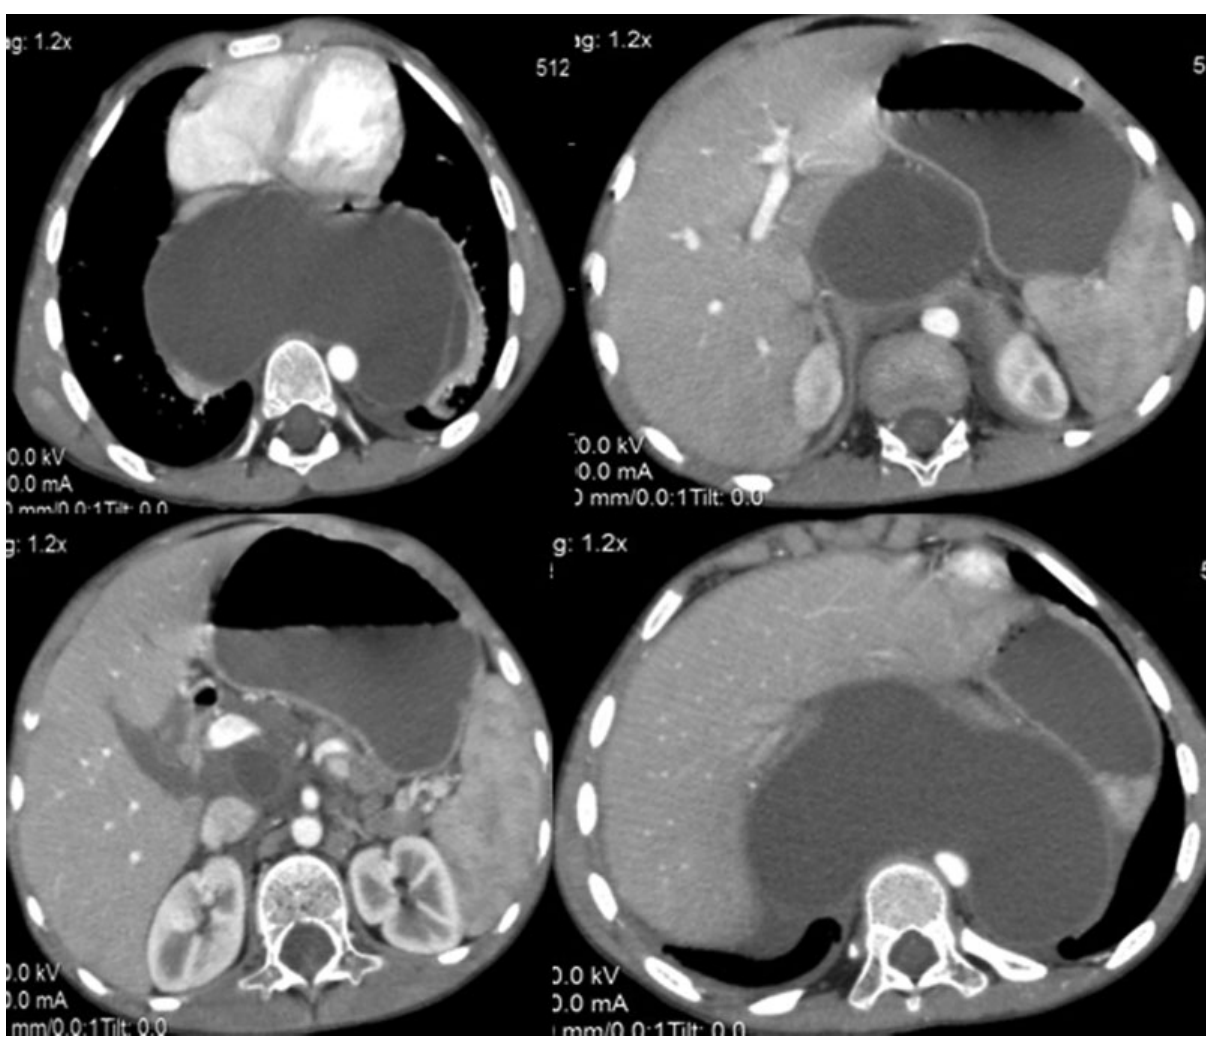
Fig. 1 CT abdomen showing fl uid containing cystic mass behind the stomach around the pancreas extending up to the chest. CT, computed